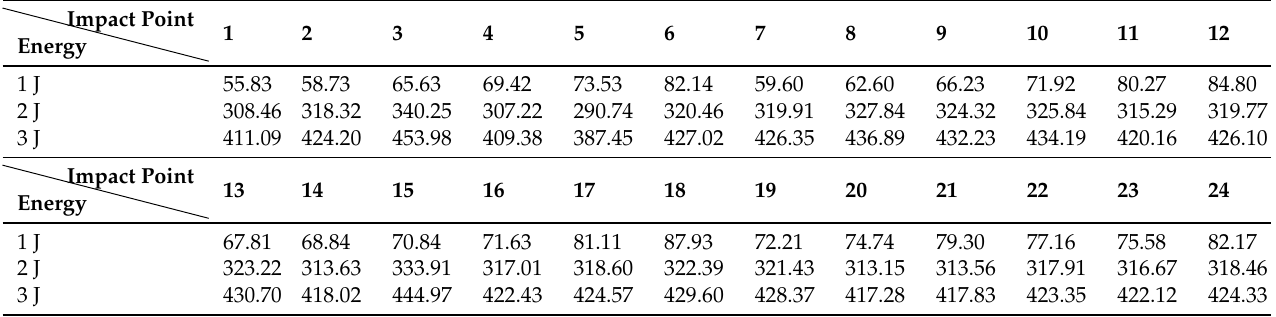
Figure 9. Spectrum of the third-order component of the signals at the impact point a (60 mm, 160 mm) using whitening EMD algorithm. Table 5. Impact energy eigenvalues of the variable thickness composite laminate at 1–3 J.